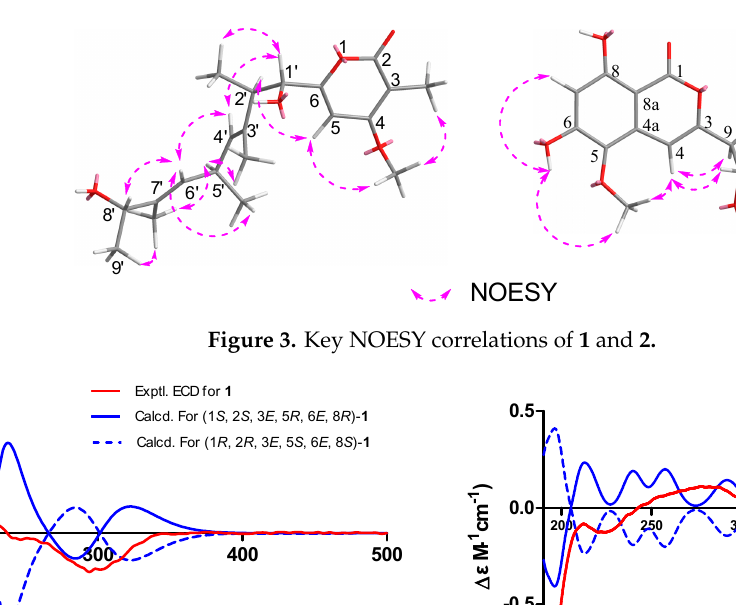
- -: not detectable. Table 2. Cytotoxicity data of compounds 1 – 5 . a. Cell Line